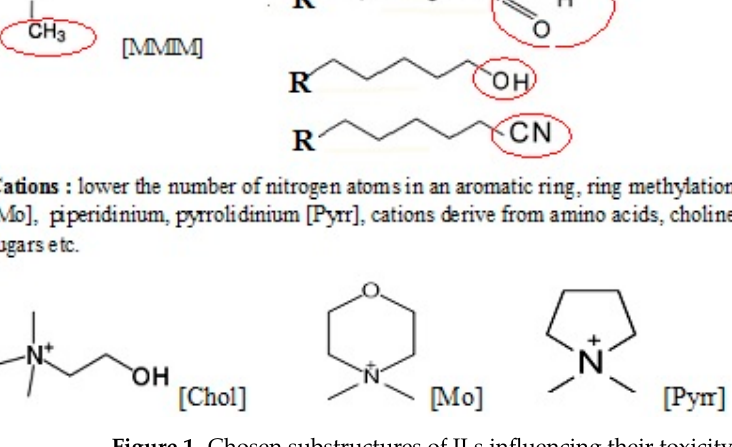
Figure 1. Chosen substructures of ILs influencing their toxicity.